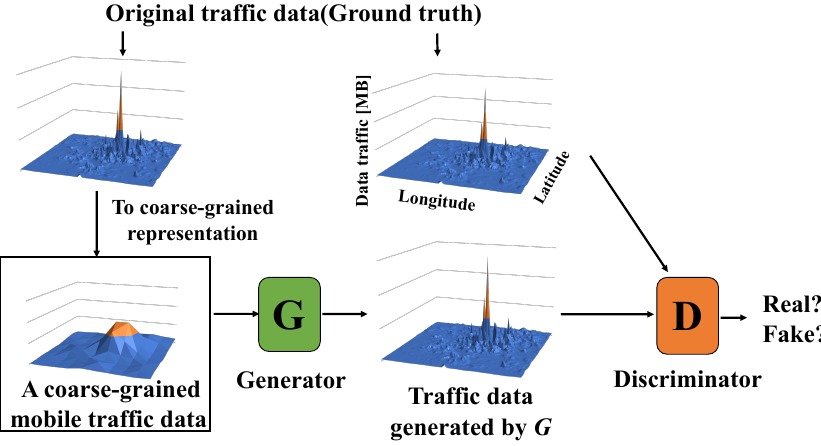
Figure 1. The abstraction of a scheme of generating mobile traffic data by using